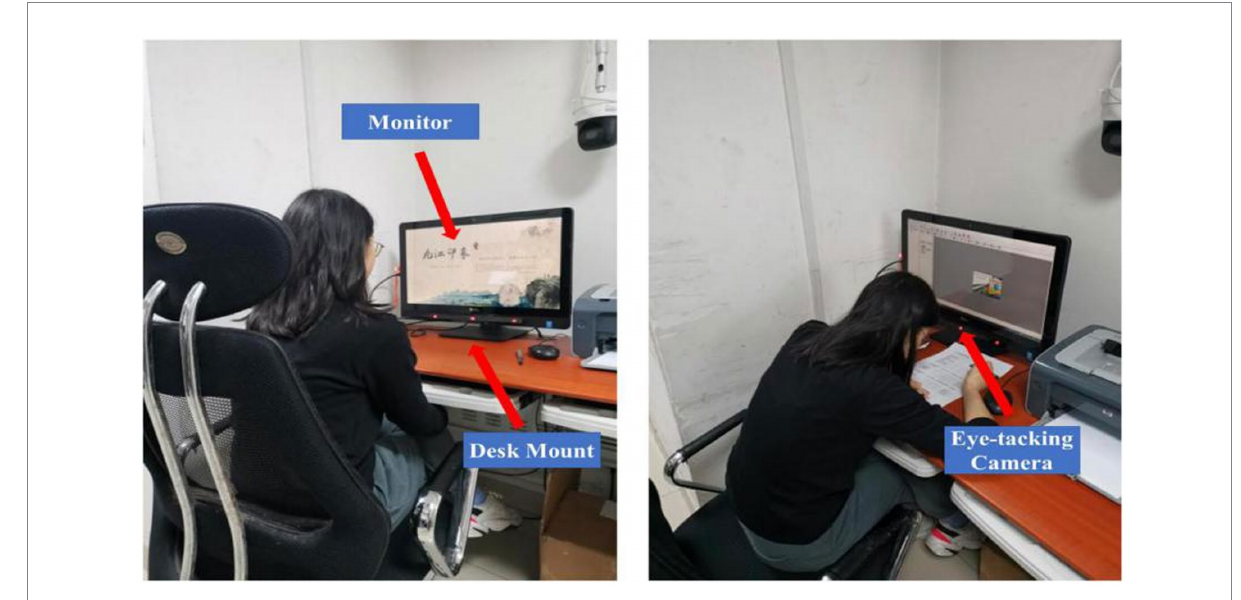
FIGURE 3 Experiment procedure. Source: photographed by research